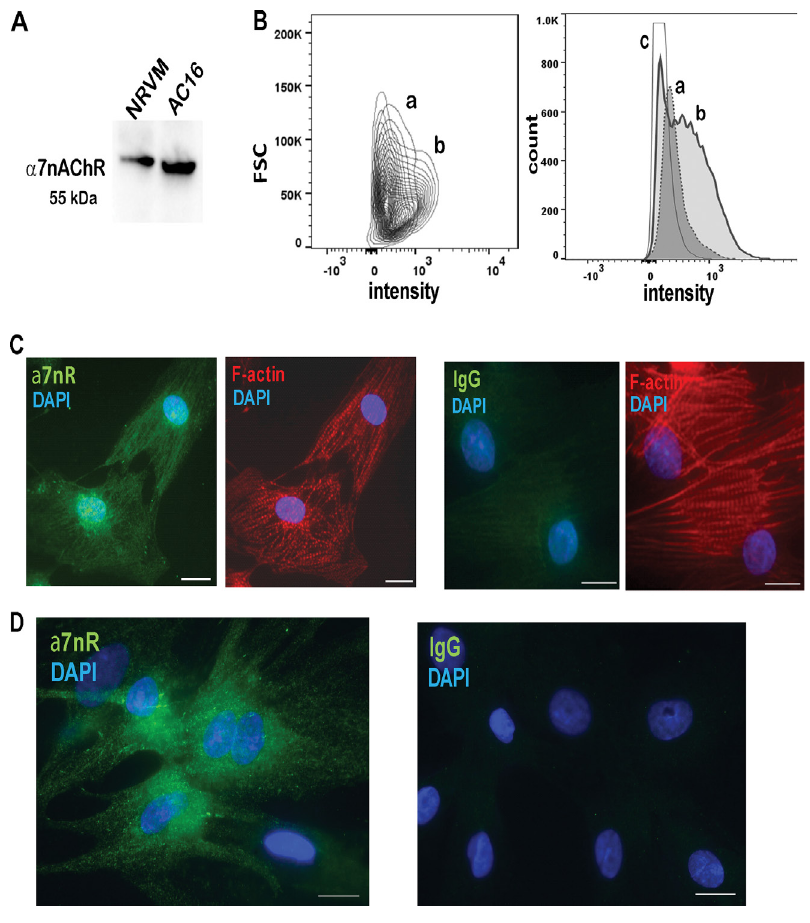
Figure 5. Localization of α 7nAChRs in cultured cardiomyocytes. (A) Immunoblot analysis of α 7nAChR (55 kDa) in total lysates of neonatal rat ventricular myocytes (NRVM) and adult human cardiomyocytes AC16. (B) FACS analysis of intact AC16 cells sorted by intensity of bound anti- α 7nAChR antibody versus forward scatter (FSC). Contour map ( left ) shows distinct populations of cells that are quantified in the histogram ( right ): cells in peak-b are bound with fluorescence-labeled antibody; cells in peak-a were incubated with antibody preadsorbed with peptide immunogen; cells incubated with isotype con- trol IgG are in peak-c. (C) Fluorescence microscopy localized α 7nAChR (a7nR) in NRVM using a rabbit anti- α 7nAChR antibody and FITC-labeled secondary antibody. Counter- staining with TRITC-labeled phalloidin identified F-actin in cardiomyocytes. Using identical exposure settings, isotype rabbit IgG showed low background fluorescence in myocytes stained for F-actin. Scale bars represent 20 μ m. (D) Micrographs taken at the same expo- sure settings show strong localization of anti- α 7nAChR antibodies to NRVMs while the IgG isotype control is weakly fluorescent. Scale bars, 20 μ